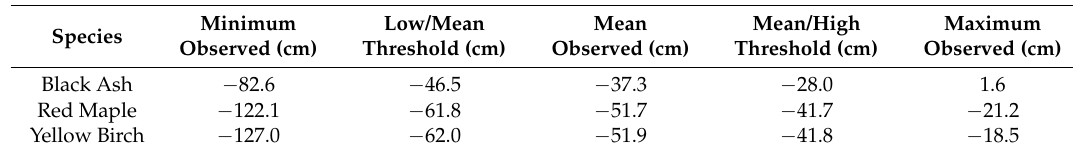
Table 2. Range of observed water levels (cm) for each species and water level bin. Water levels are reported as distance above (+) or below ( − ) the tree root collar.